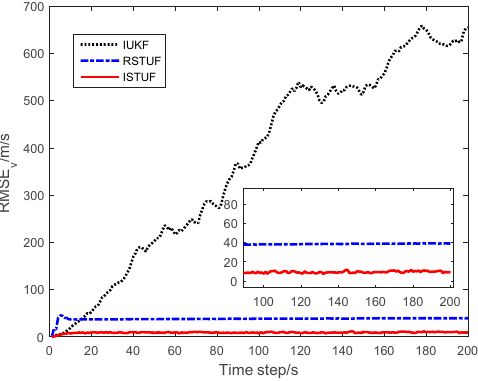
Figure 6. RMSE of estimating position.